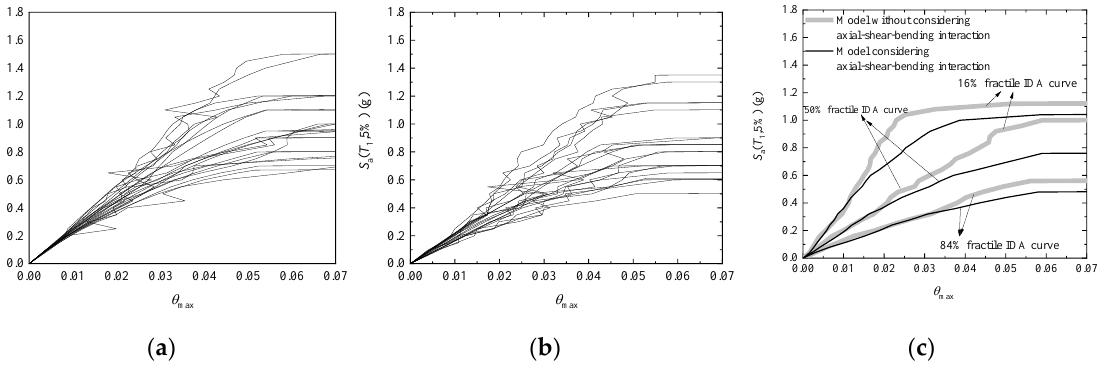
Figure 17. IDA curves with and without considering axial–shear–bending interaction of RC columns. ( a ) Model without considering the axial–shear–bending interaction of columns. ( b ) Model considering the axial–shear–bending interaction of columns. ( c ) The 16%, 50%, and 80% fractile IDA curves. max Based on FEMA350, S a ( T 1 , 5% ) and θ max as the intensity measure (IM) and damage measure (DM) values, respectively, were used to assess the collapse resistance capacity of the infilled RC frames [30]. The value of θ max = 0.05 and the slope of the IDA curve attained a 20% initial slope gradient constituting the collapse criterion [31–34]. For each S a ( T 1 , 5% ) , θ max and the slope of the IDA curves were calculated to acquire the probability of collapse. For certain S a ( T 1 , 5% ) values, the probability of collapse was defined as n c / n t . n c is the number of ground-motion records corresponding to the occurrence of collapse. n